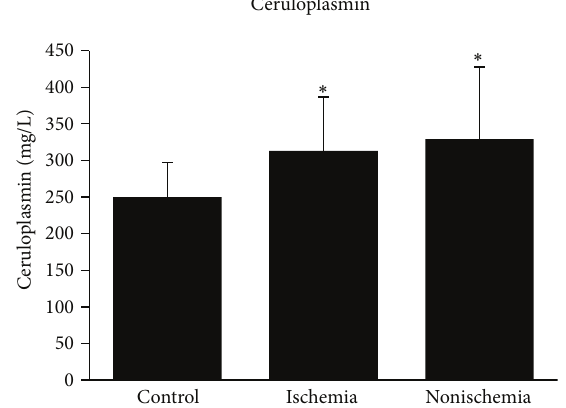
Figure 1: Ceruloplasmin levels in control, ischemic, and nonis- chemic cardiomyopathy groups. CP levels in ischemic and non- ischemic cardiomyopathy groups were higher than those in the control group (𝑃 < 0.001) . No difference was found between the ischemic and nonischemic cardiomyopathy groups. ∗ 𝑃 < 0.001 versus control group.